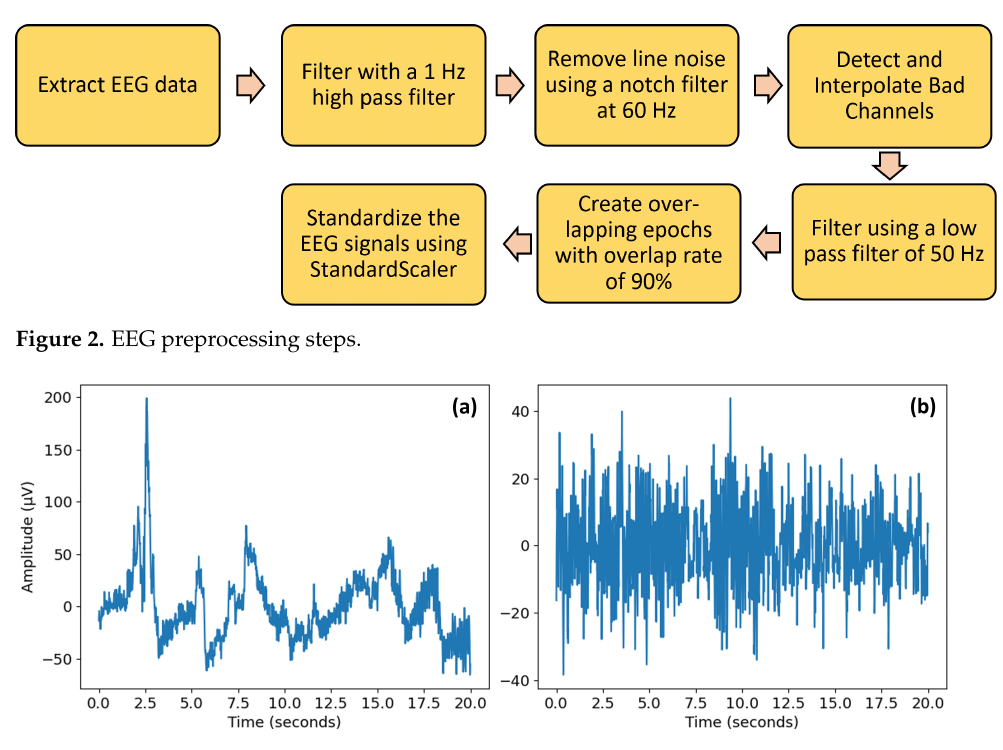
Figure 3. EEG epoch ( a ) raw data; and ( b ) preprocessed